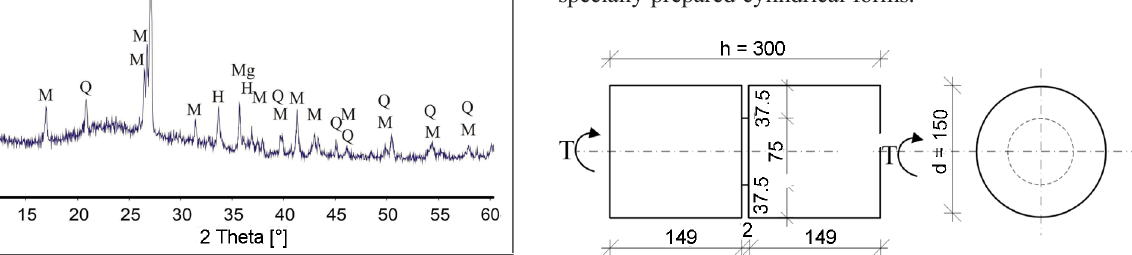
Fig. 2. Geometrical configuration of tested specimen (dimensions in mm, T –